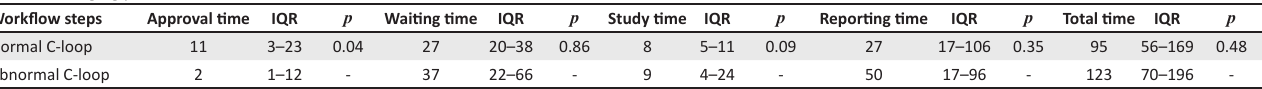
TABLE 2: Imaging parameters. Workflow steps